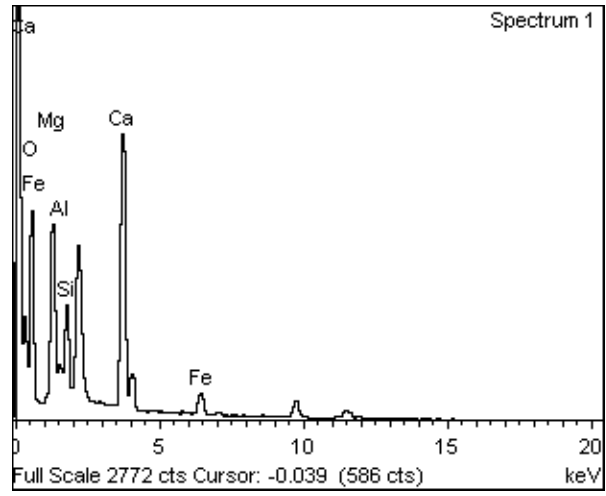
Figure 10. EDX spectrum of EOF steel slag.